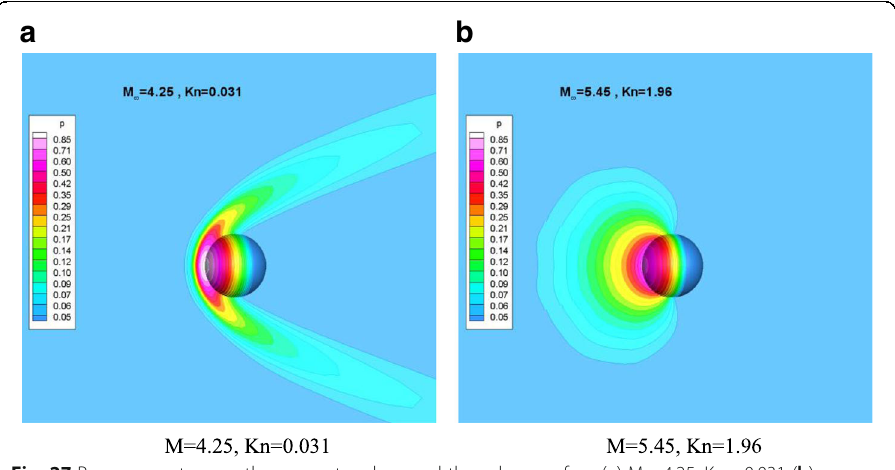
Fig. 27 Pressure contour on the symmetry plane and the sphere surface ( a ) M = 4.25, Kn = 0.031 ( b ) M = 5.45, Kn = 1.96